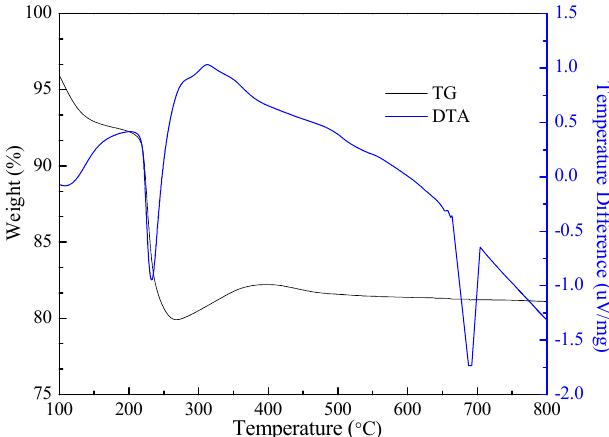
Figure 12. Thermal (TG-DTA) analysis of the VO(OH) 2 in air atmosphere.